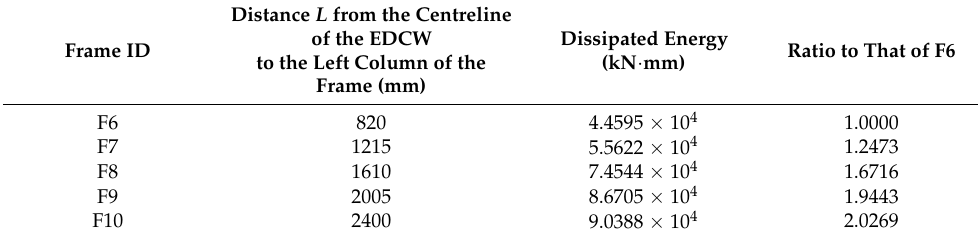
Figure 17. Hysteresis curves of the EDCWs installed at different locations. ( a ) F6; ( b ) F7; ( c ) F8; ( d ) F9; and ( e ) F10. Table 6. Cumulative dissipated energies of the EDCWs.